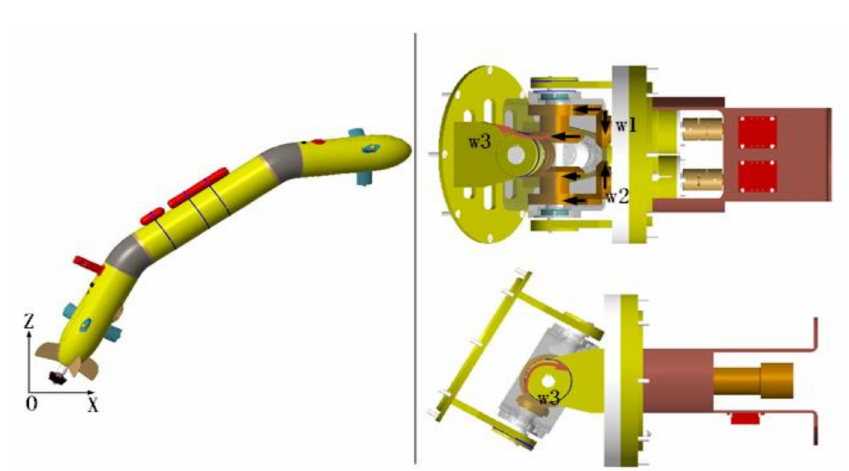
Figure 2. Orthogonal joint pitching